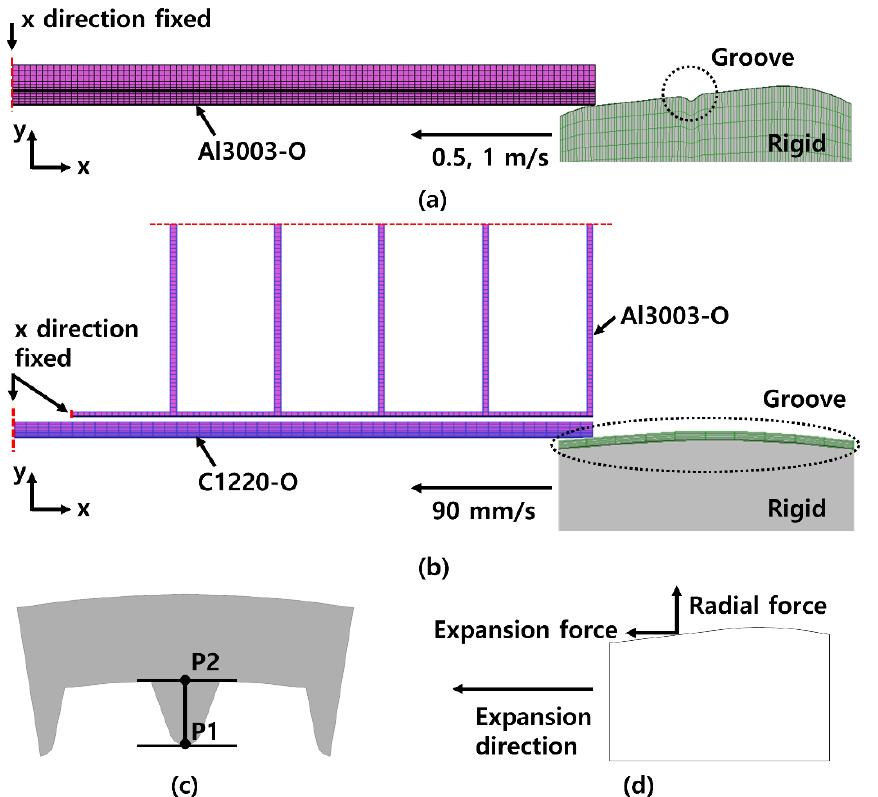
Figure 5. FE models and boundary conditions for the analysis of ( a ) Al tube and ( b ) Cu tube expansions; ( c ) reference points P1 and P2 for calculating the tube’s inner groove deformation; and ( d ) axial and radial forces.